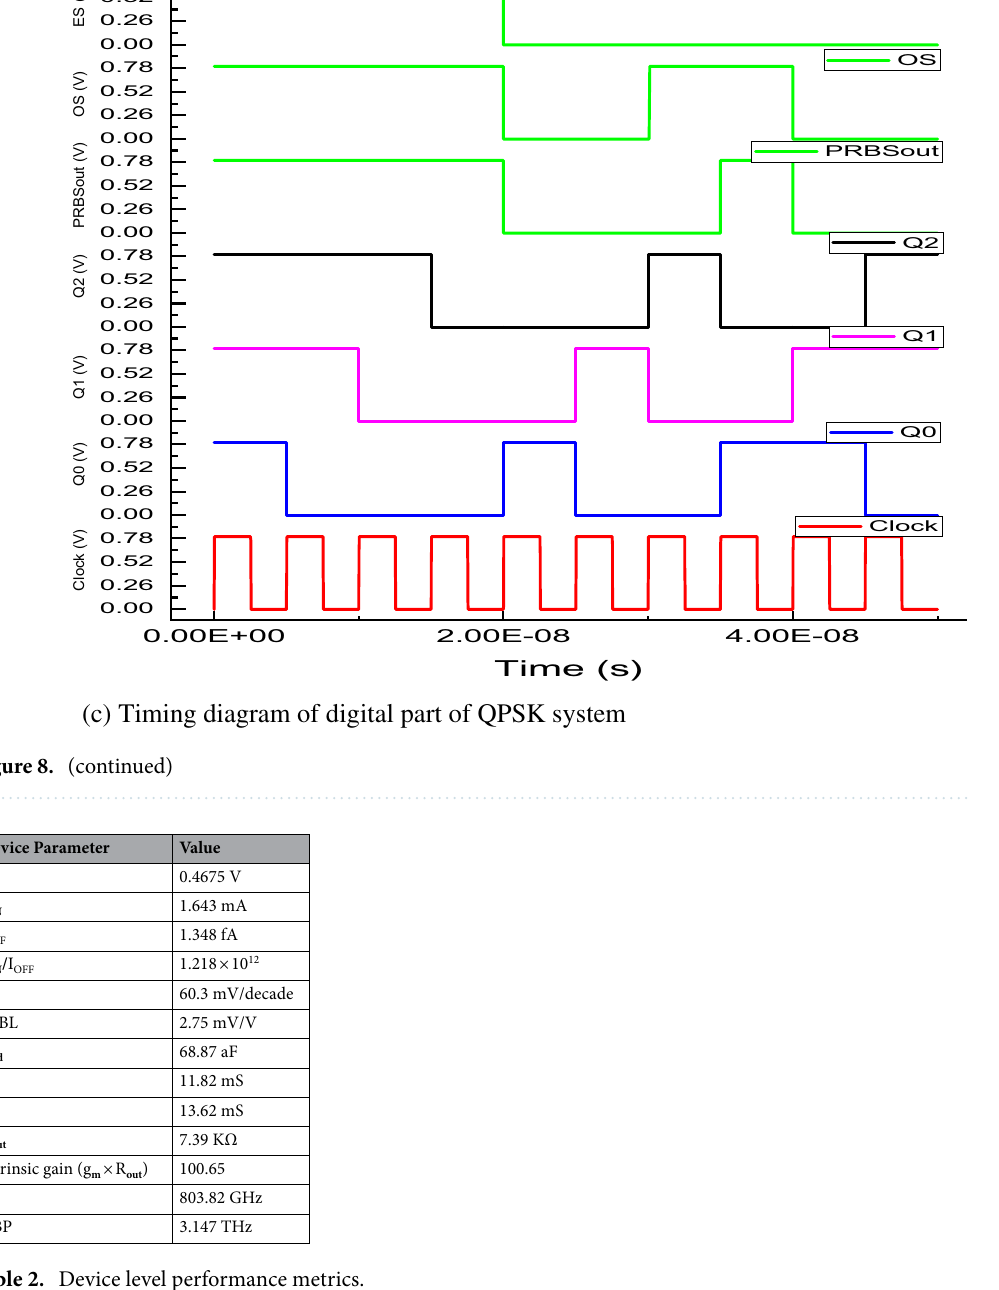
Table 2. Device level performance metrics.